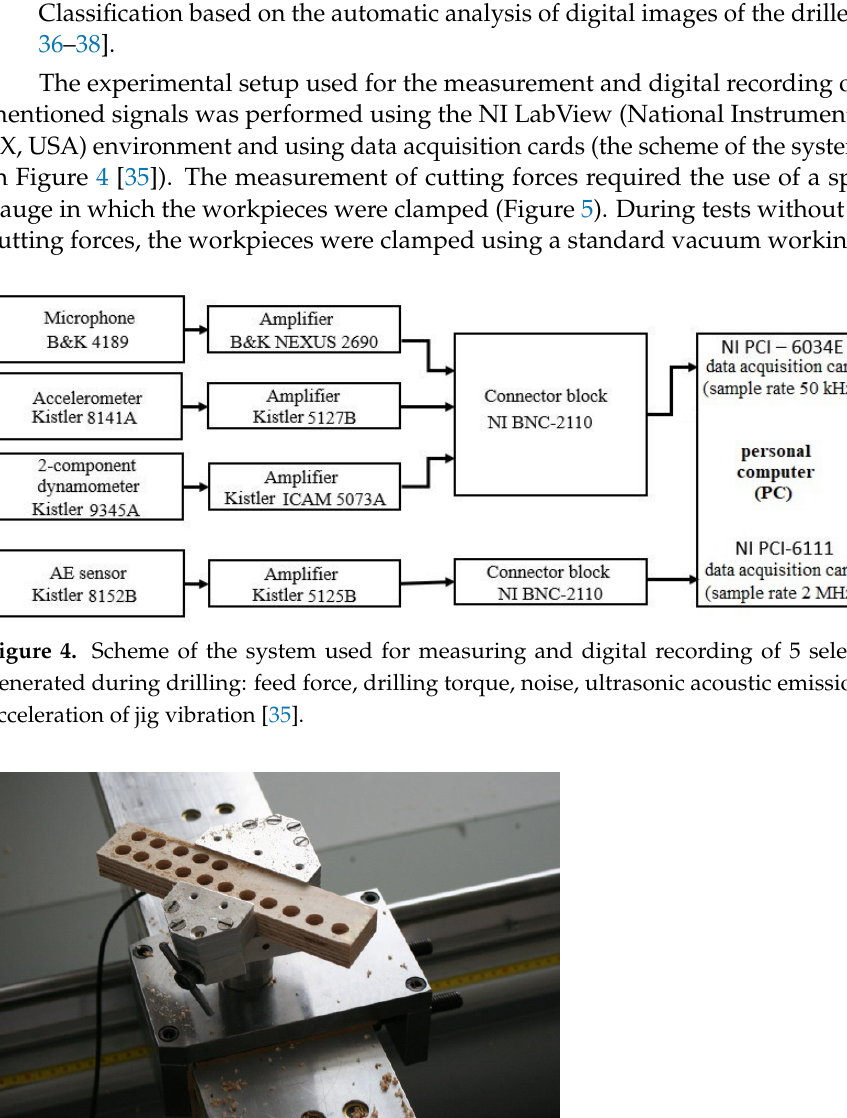
Figure 5. The special force gauge in which the workpieces were clamped.